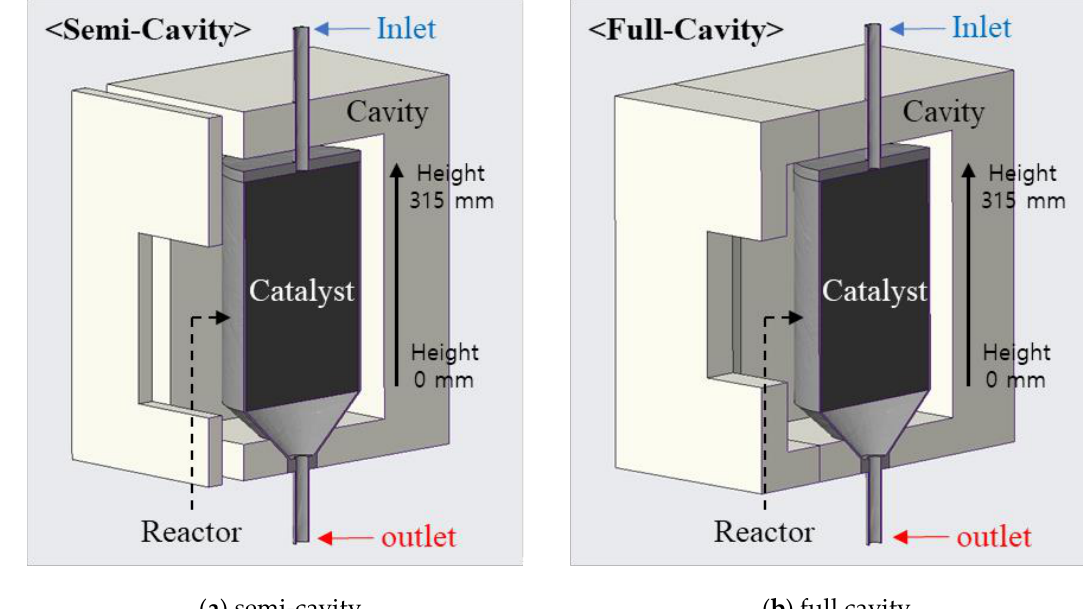
Figure 7. 3D modeling of reactor and cavity.